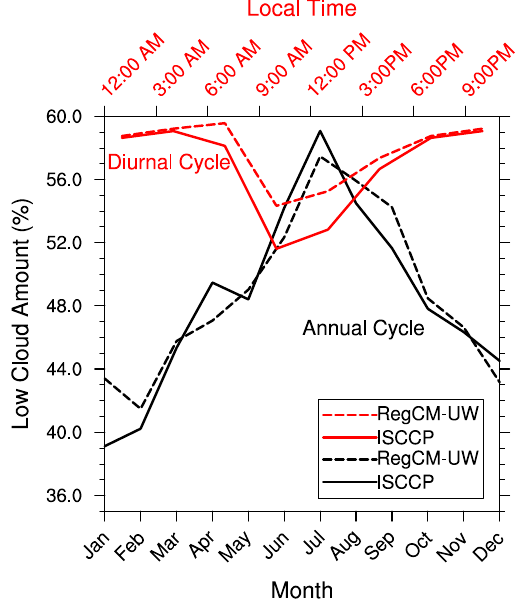
Fig. 12. The annual and diurnal cycles of low cloud coverage, av- eraged from 1985 to 2006. The solid curves show ISCCP satellite measurements of low cloud amount, and the dashed curves show the modeled RegCM-UW low cloud amount shifted downward by 25% for clarity (meaning RegCM-UW is biased approximately 25% too high). The solid curves depict the average annual cycle and the red curves depict the average JJA diurnal